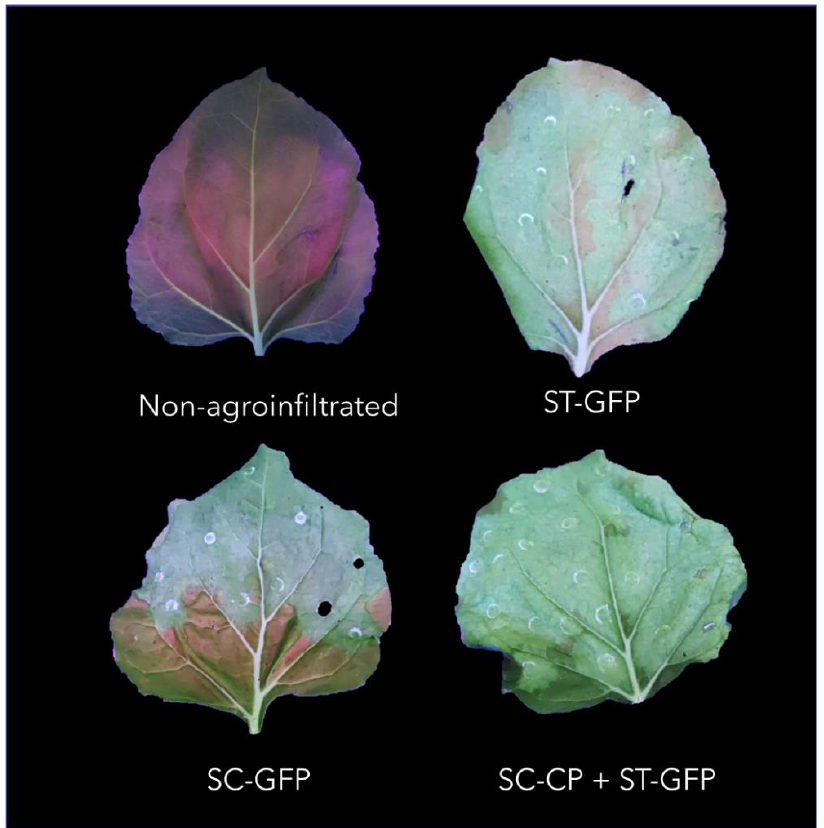
Figure 3. Agroinfiltrated leaves with different VLPs constructs under UV light compared with a non-agroinfiltrated leaf. ST: SpyTag; SC: SpyCatcher; CP: TuMV capsid protein; GFP: green fluorescent protein.